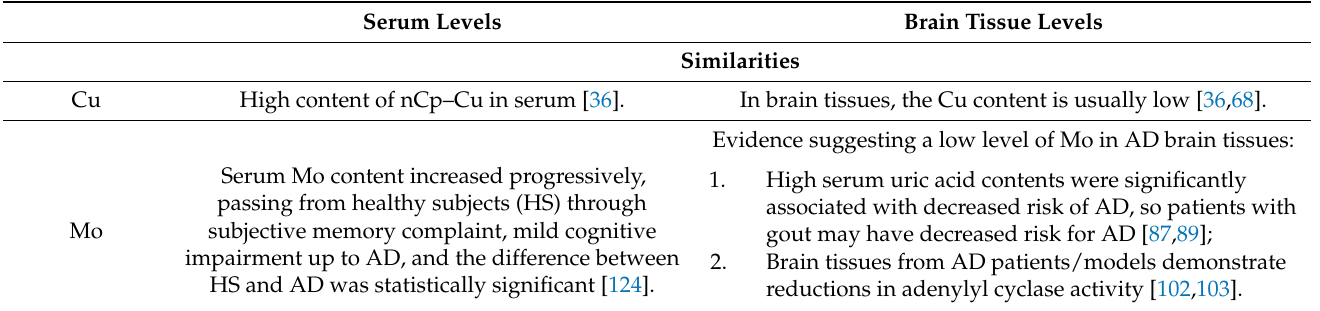
Brain tissues from AD patients/models demonstrate reductions in adenylyl cyclase activity